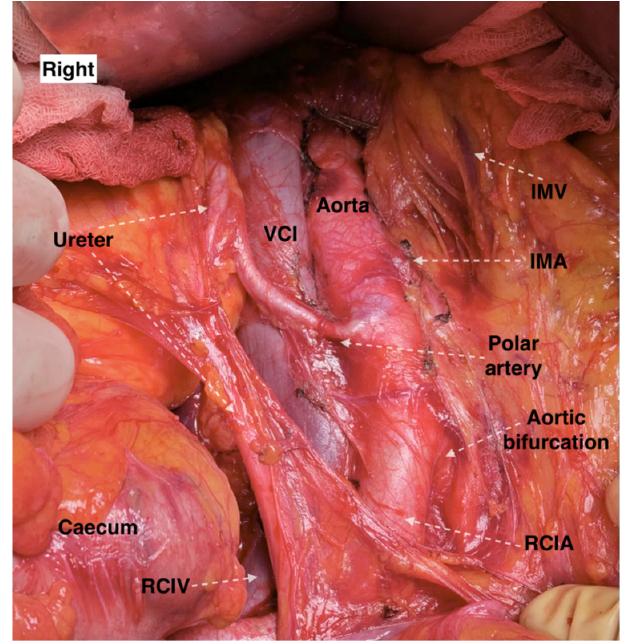
Figure 8. Additional right aortic upper polar renal artery with precaval course, which arises from the anterolateral aspect of the abdominal aorta (an open surgery performed by doctor Ilker Selcuk). IMV—inferior mesenteric vein, IMA—inferior mesenteric artery, RCIA—right common iliac artery, RCIV—right common iliac vein, VCI—vena cava inferior.